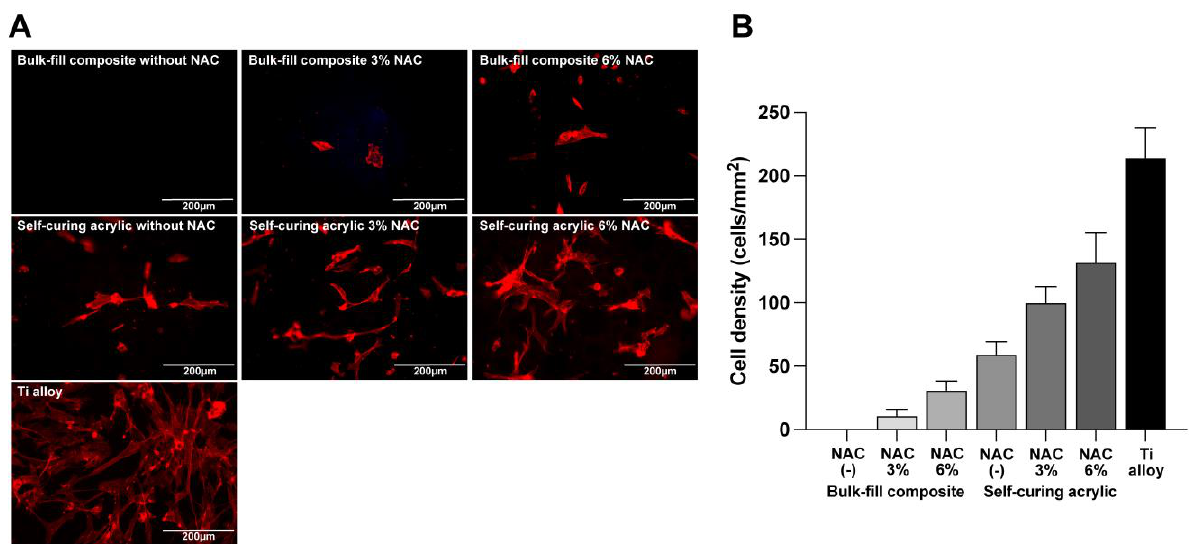
Figure 5. Fibroblasts visualized on materials with or without NAC impregnation. ( A ) Fluorescence microscopy images of fibroblasts on culture day four stained for cytoskeletal actin filaments (red). ( B ) Cell density was quantified based on the images.